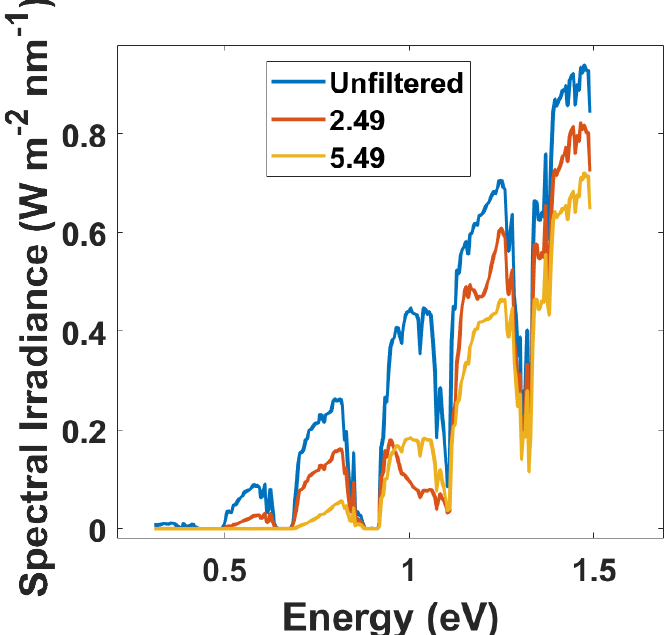
Figure 6. Transmission of the Sun (direct and circumsolar irradiation [29]) without the photonic crystal filter (blue curve), with an ITO:TiO 2 60:10 sample characterized by a doping level of 2.49 × 10 26 charges m 3 ⁄ (red curve) and 5.49 × 10 26 charges m 3 ⁄ (yellow curve).